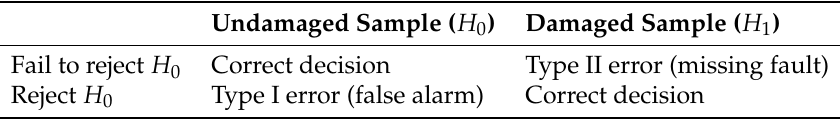
Table 5. Scheme for the presentation of the results in Table 6.